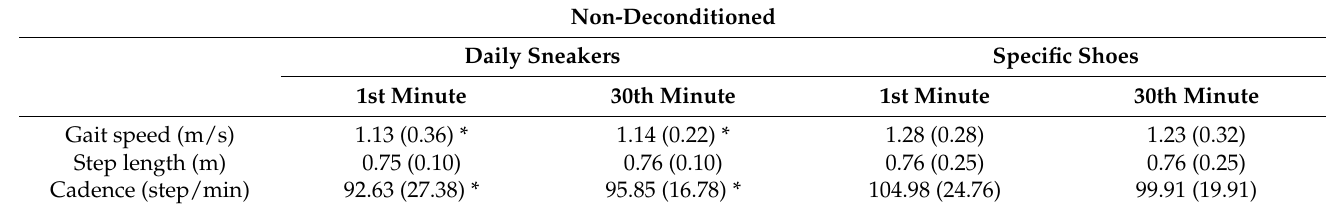
Table 5. Mean and standard deviation of parameters during the outdoor 30-min gait test for the non-deconditioned group during the early (1st minute) and last (30th minute) segment of the test during the two sessions (daily sneakers vs. specific-obesity shoes). * = p < 0.05, statistically significant in the post hoc comparison daily sneakers vs. specific-obesity